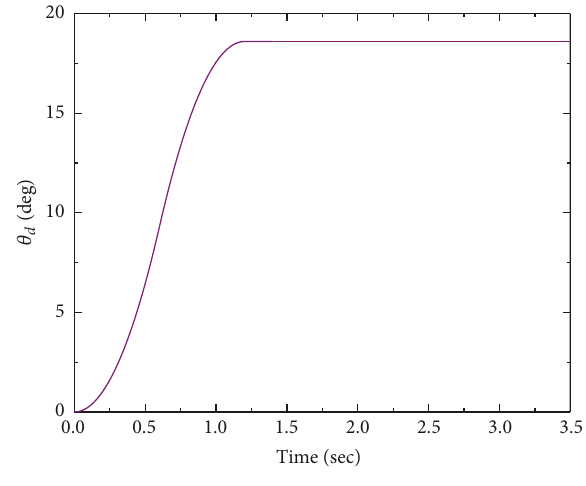
Figure 8: Desired trajectory of 𝜃